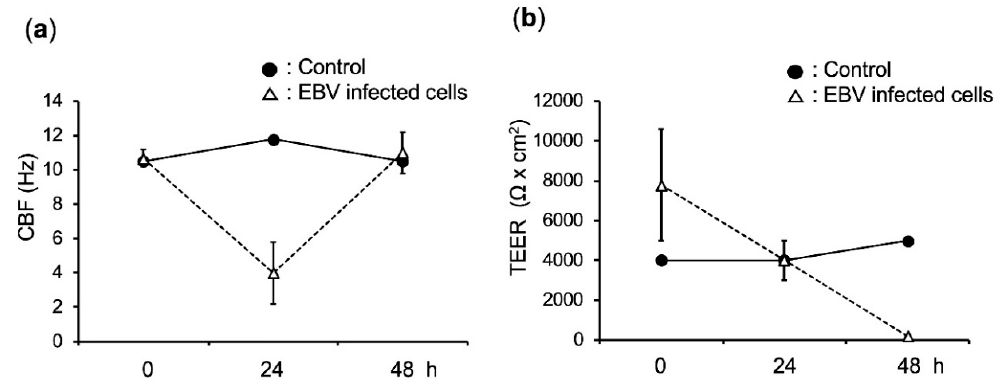
Figure 5. Effects of EBV infection on CBF and TEER. ( a ) CBF and ( b ) TEER were measured at different time points (0, 24, and 48 h). The virus-producing Akata cells were added for infection and removed after 24 h by washing. Control cells were EBV-negative Ramos cells.